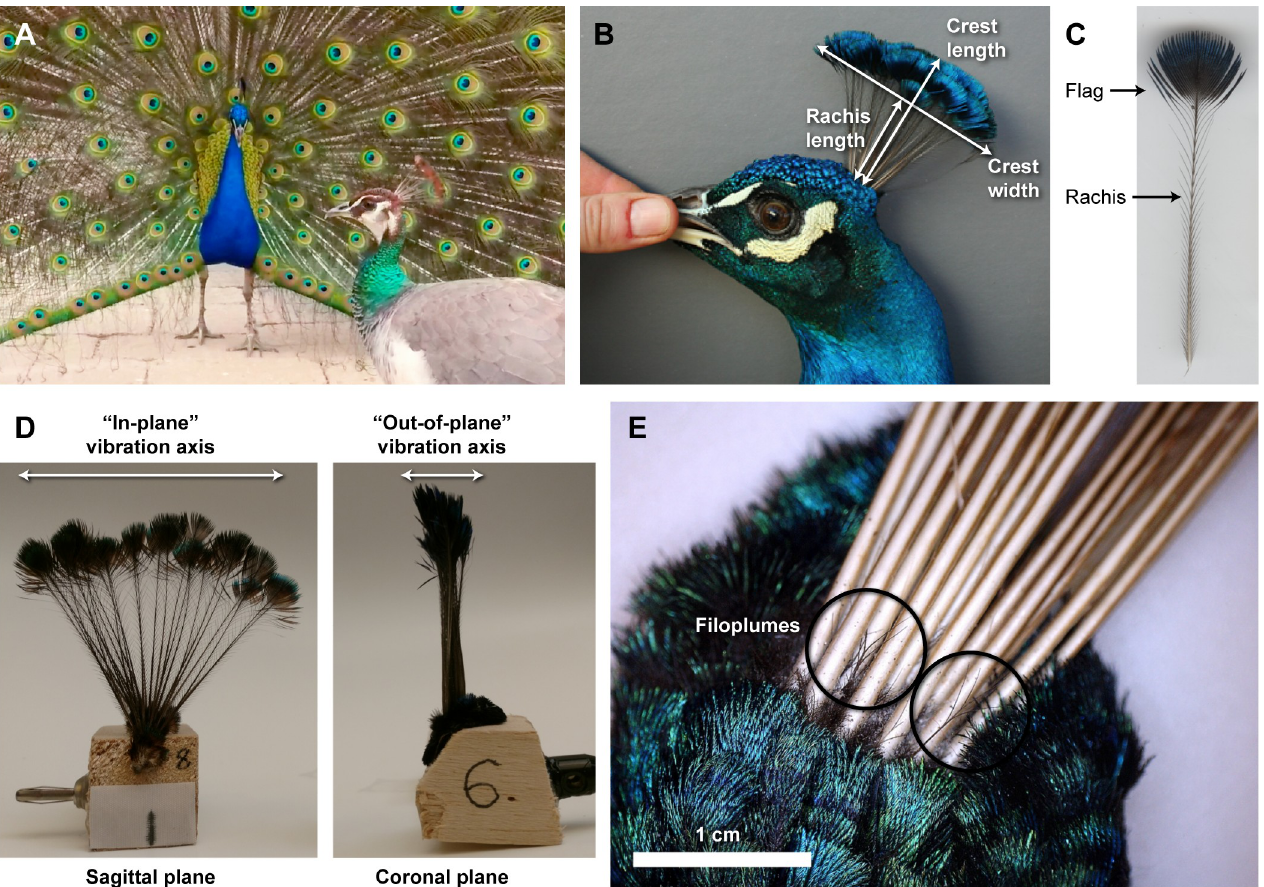
Fig 1. Morphology of peafowl crests and crest feathers. (A) A peahen (foreground) with the plane of her crest oriented towards the displaying peacock (background) as he performs train-rattling vibrations. (B) Both sexes have a crest with an inverted pendulum shape made up of between 20–31 feathers. This photo shows an adult male measured in vivo . (C) A single crest feather showing the pennaceous flag at the distal end. Note that only short, thin barbs are present on the relatively bare rachis (shaft) at the proximal end. (D) A whole crest sample mounted for the laboratory experiments. The two axes of vibrational motions (“in-plane” and “out-of-plane”) are indicated. (E) Mechanosensory filoplumes (circled) are located at the base of the peafowl crest feathers.